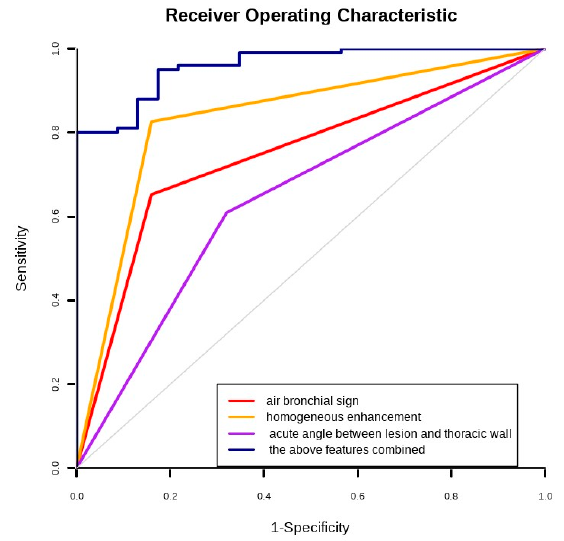
Figure 6. Receiver operating characteristic curves for air bronchial sign, homogeneous enhancement, acute angle between lesion border and thoracic wall, and the above features combined.